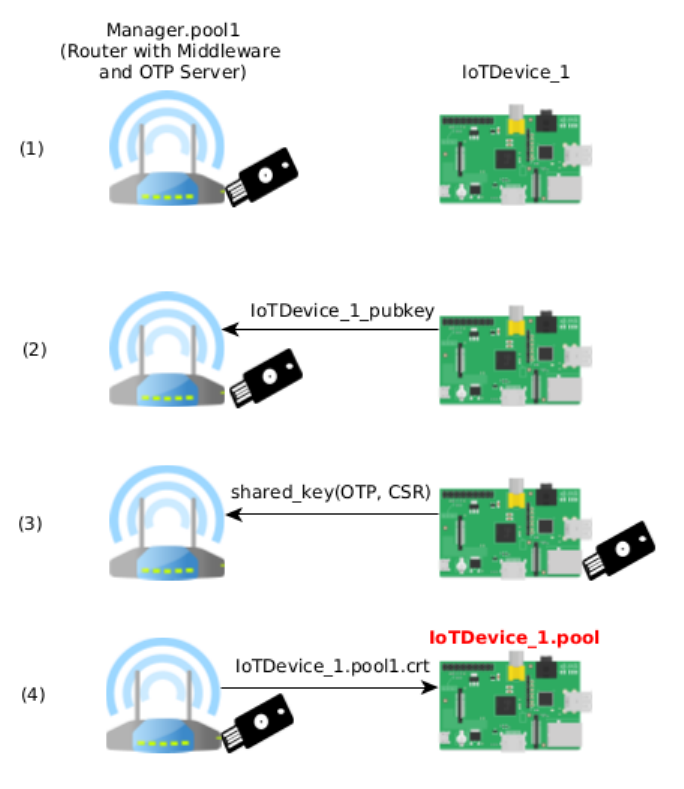
Figure 1. Setup and